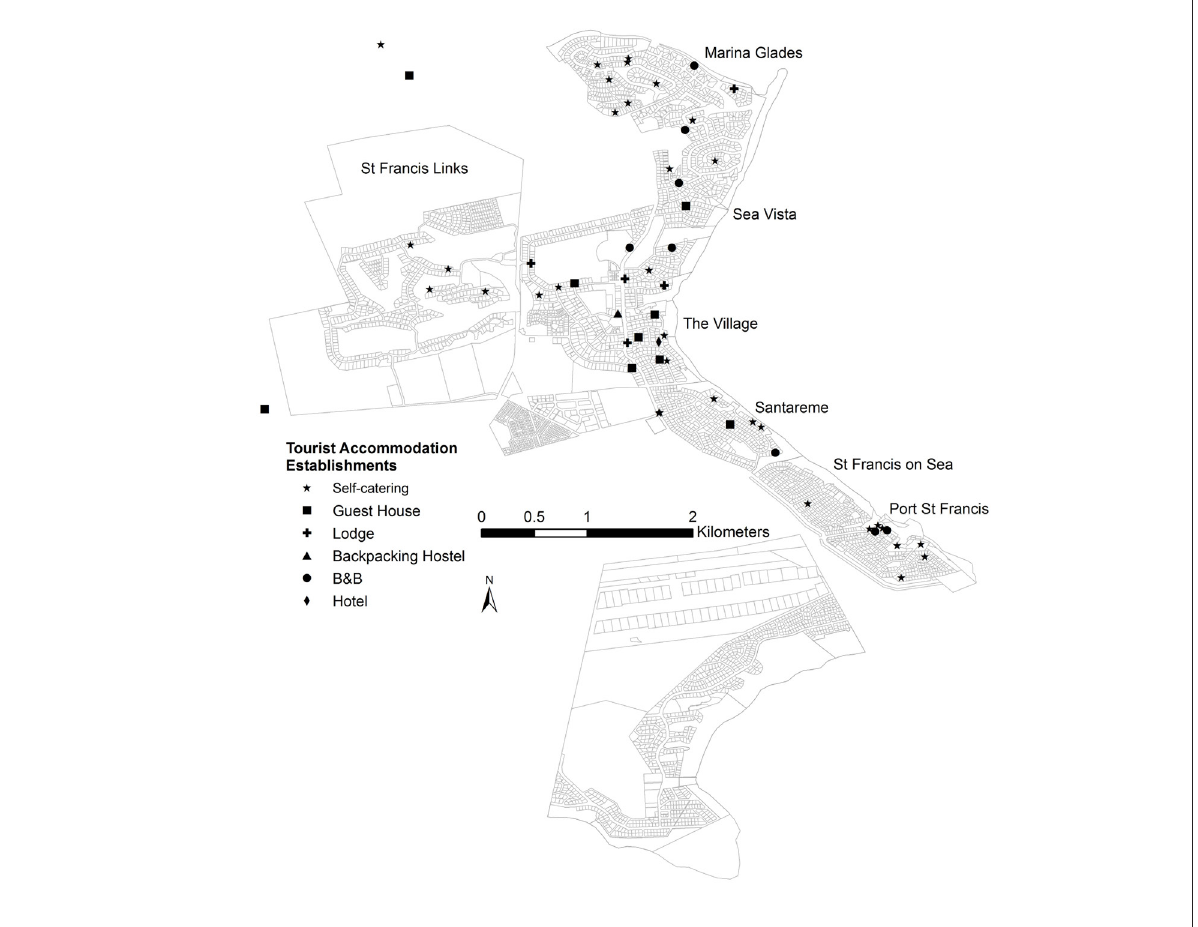
Source: Authors’ map drawn for the study Figure 2: Map indicating the locations and types of tourism accomm odation establishments in St Francis Bay.